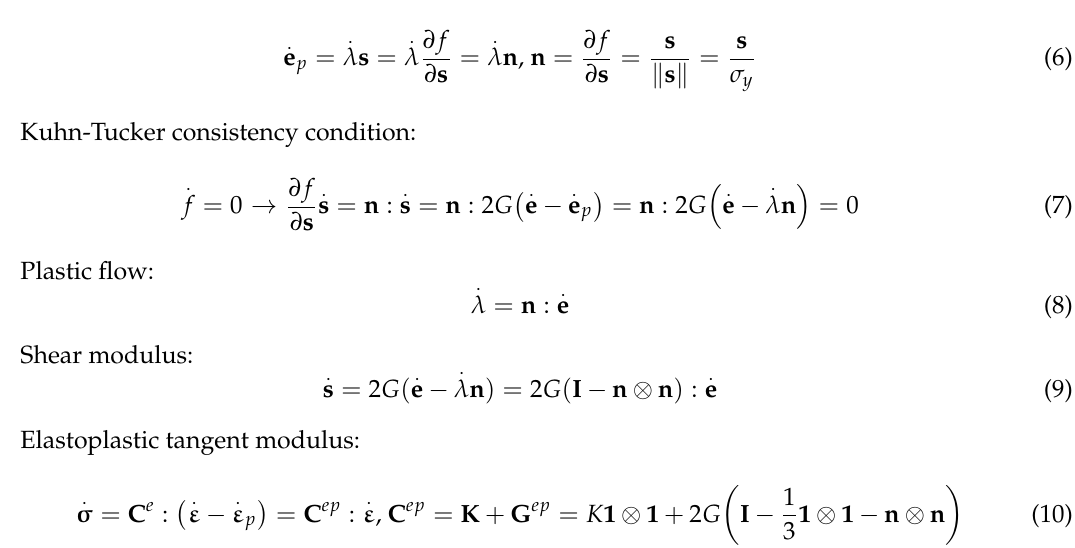
Figure 1. Failure surface of J 2 plasticity: ( a ) principal stress space, ( b ) deviatoric stress space. Flow rule and unit direction tensor: